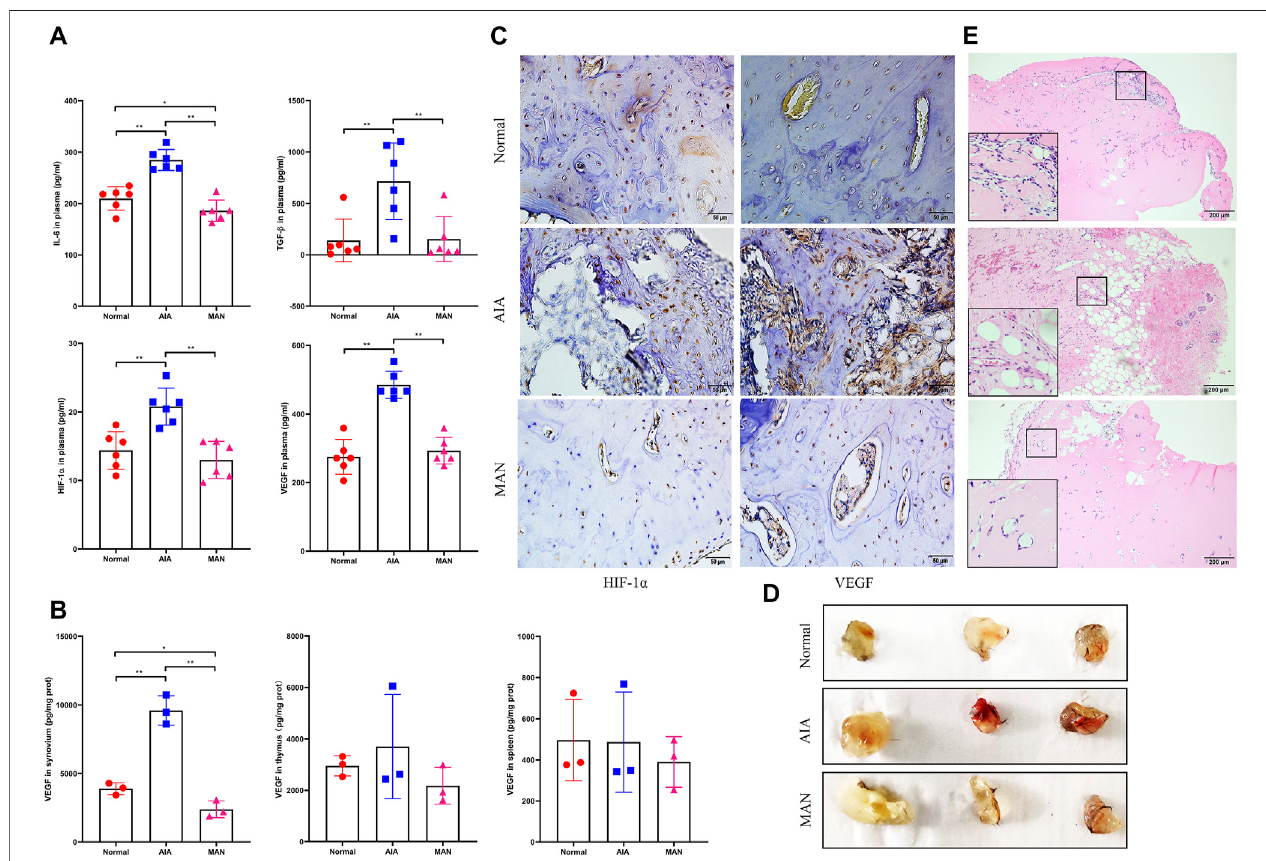
FIGURE 2 | MAN inhibited pathological angiogenesis in AIA rats. (A) , levels of angiogenic cytokines in plasma ( n (cid:2) 6); (B) , levels of VEGF in different tissues of rats ( n (cid:2) 3); (C) ,localexpressionofHIF-1 α andVEGFincartilageofjoints; (D) ,morphologicalobservationofmatrigelplugsimplantedindifferentrats; (E) ,H&Estaining-based histological examination of above matrigel